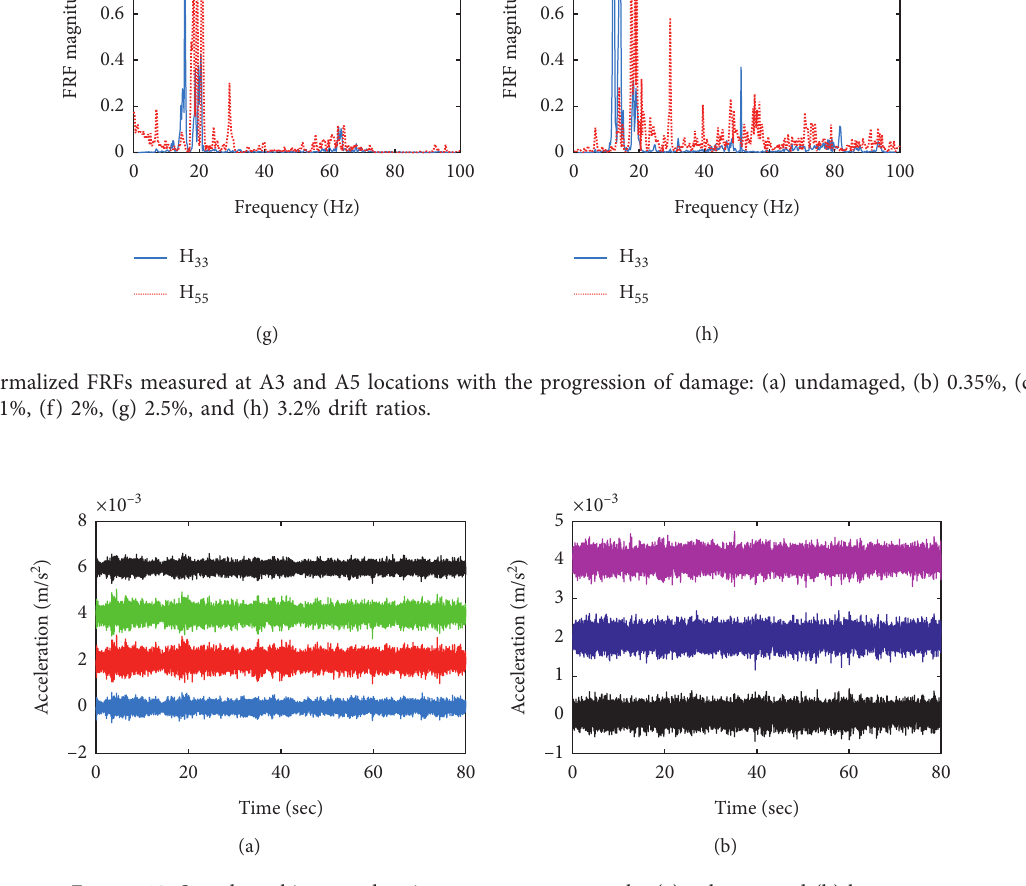
Figure 13: Sample ambient acceleration measurements on the (a) columns and (b)